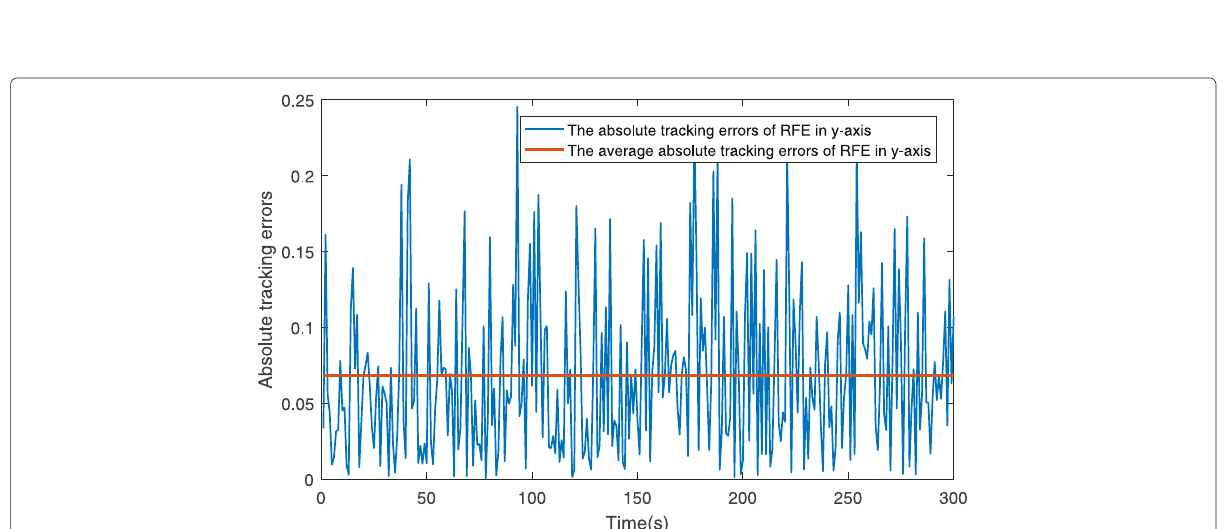
( i ) where u , i = 1, 2 are sampled from the sets { 0.5, 1, 1.5 } k and { 1.5, 2, 2.5 } in equal probability respectively. The parameters a i , i = 1, 2 are taken as a 1 = 8 and a 2 = 10. After 50 Monte Carlo runs, the comparisons of the abso- lute track errors in x -axis and y -axis are given in Figs. 18, 19, 20 , and 21.